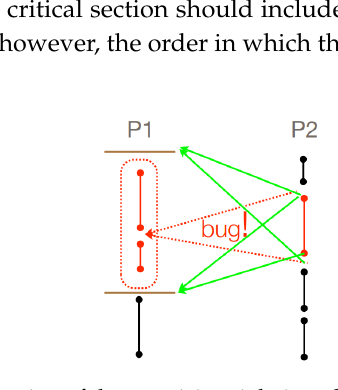
Figure 1. Visualization of the atomicity violation phenomenon. Source